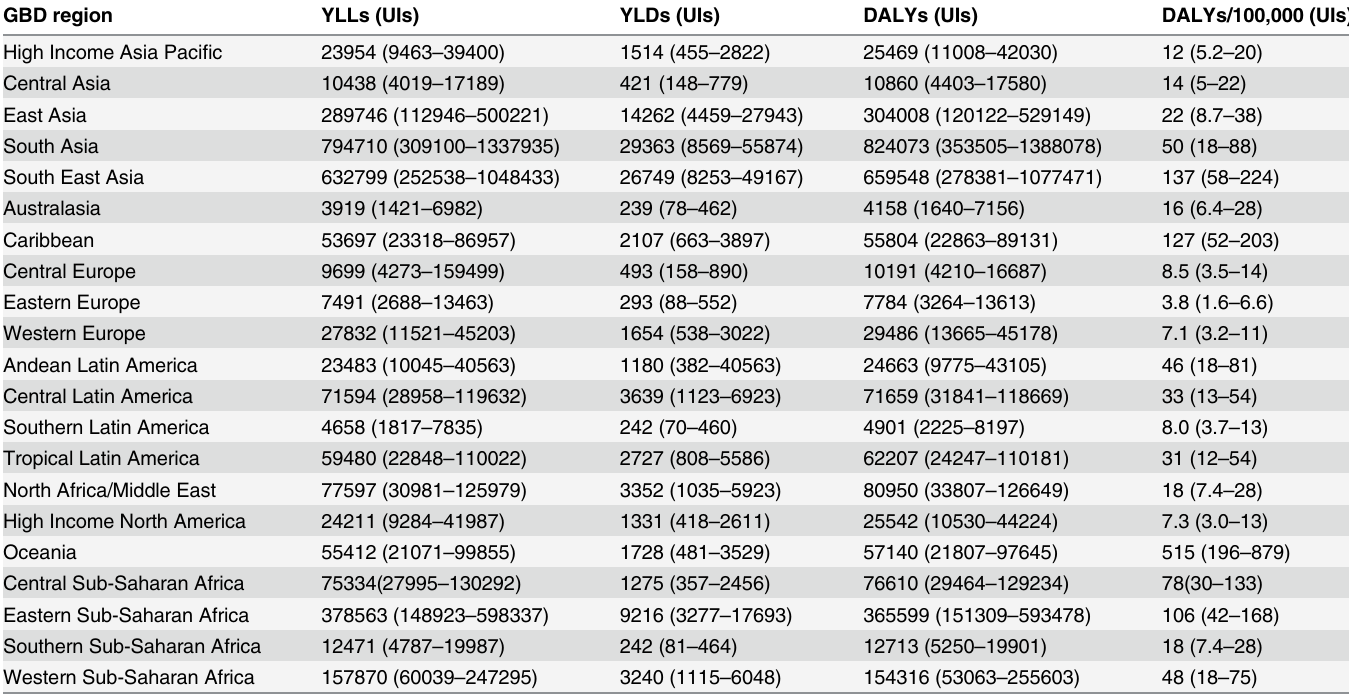
Table 4. Annual burden of disease by GBD region. Country level estimates are available in the S2 File. GBD